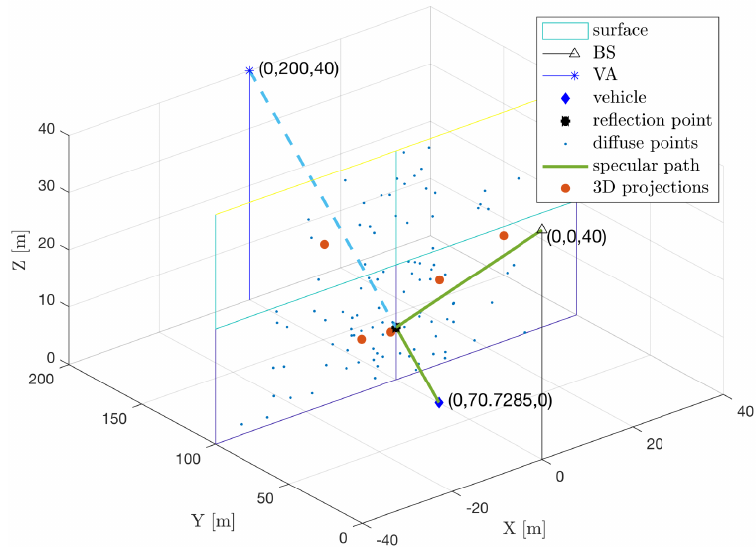
Figure 6. The 3D projection of channel estimation results of 100 diffuse path and a specular path from an MR